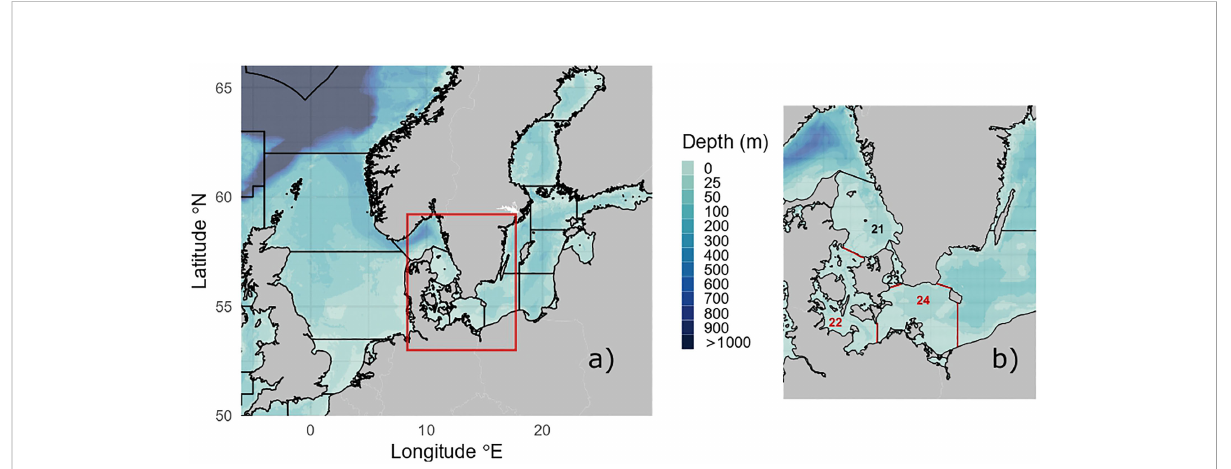
FIGURE 1 Western Baltic Sea (WBS) position in the context of the northeast Atlantic shelf region including the entire Baltic Sea region (A) . The WBS ecosystem (B) is bounded by ICES subdivisions 22 and 24 (red line). Maps were produced using R package marmap (v. 1.0.6) (Pante and Simon- Bouhet,